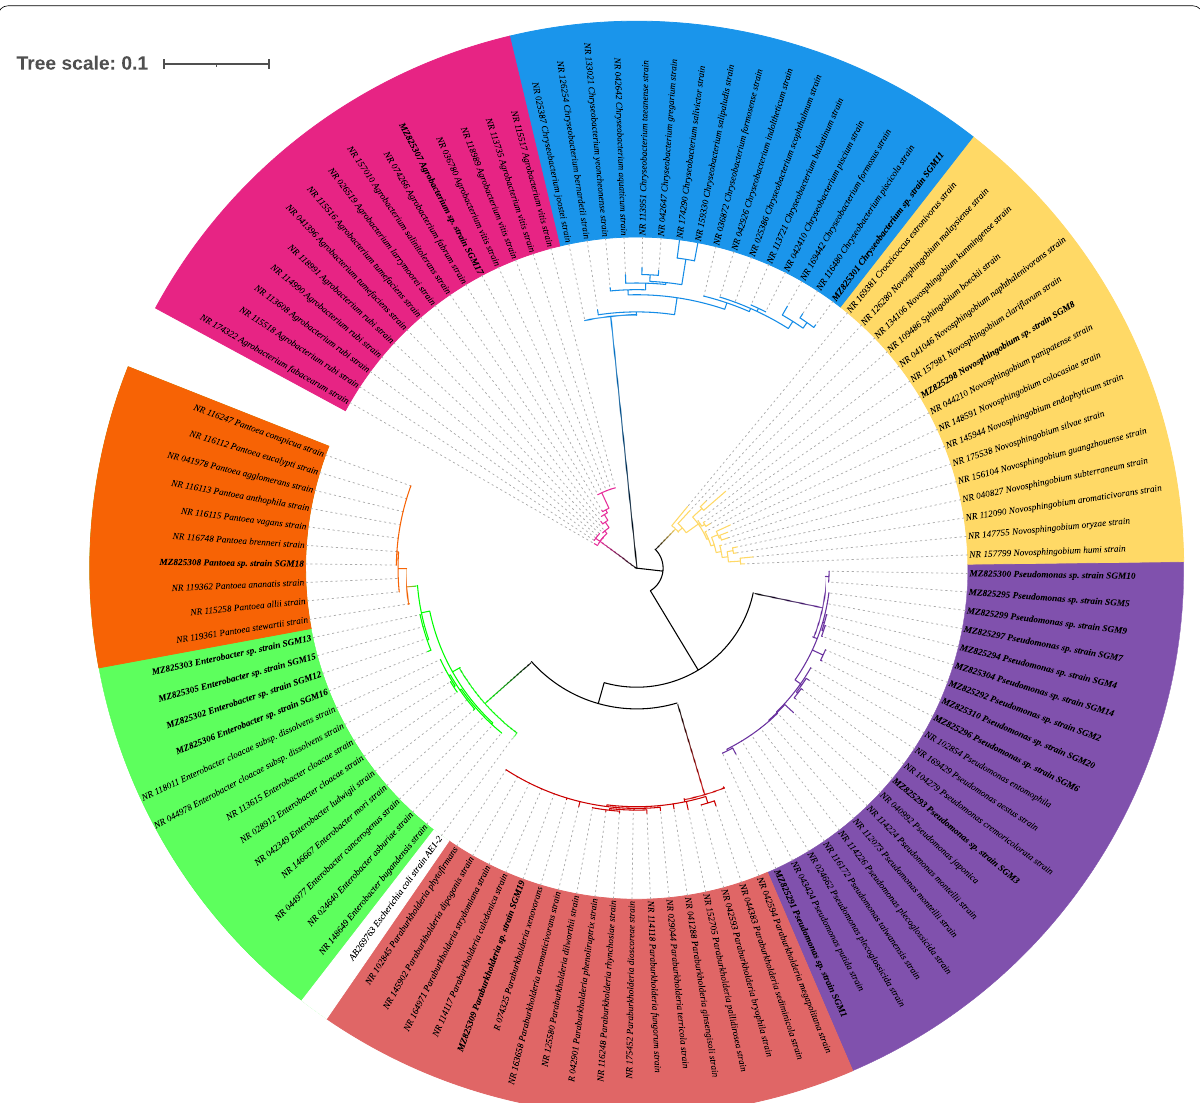
Fig. 8 Maximum likelihood phylogenetic tree constructed using the 16S rRNA gene sequences showing the relationship of the 20 endophytic bacteria of this study with closely related species. The phylogenetic tree was generated using MEGA version 11.0 with bootstrap value above 70%, 1000 replications, and visualized with Interactive Trees Of Life (iTOL). The tree is colored to indicate the different genus’s; agrobacterium, pink; Chryseobacterium , blue; Novosphingobium ; yellow, Pseudomonas ; purple; Paraburkholderia , red; Enterobacter , green; and Pantoea ,